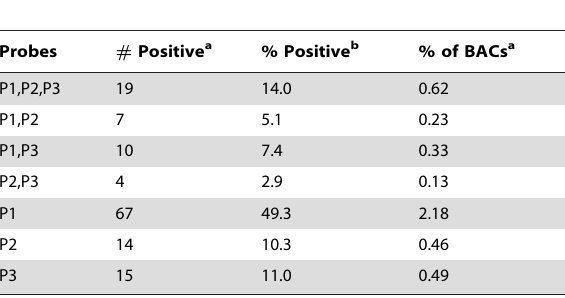
Table 2. Co-hybridization of overgo probes on BAC